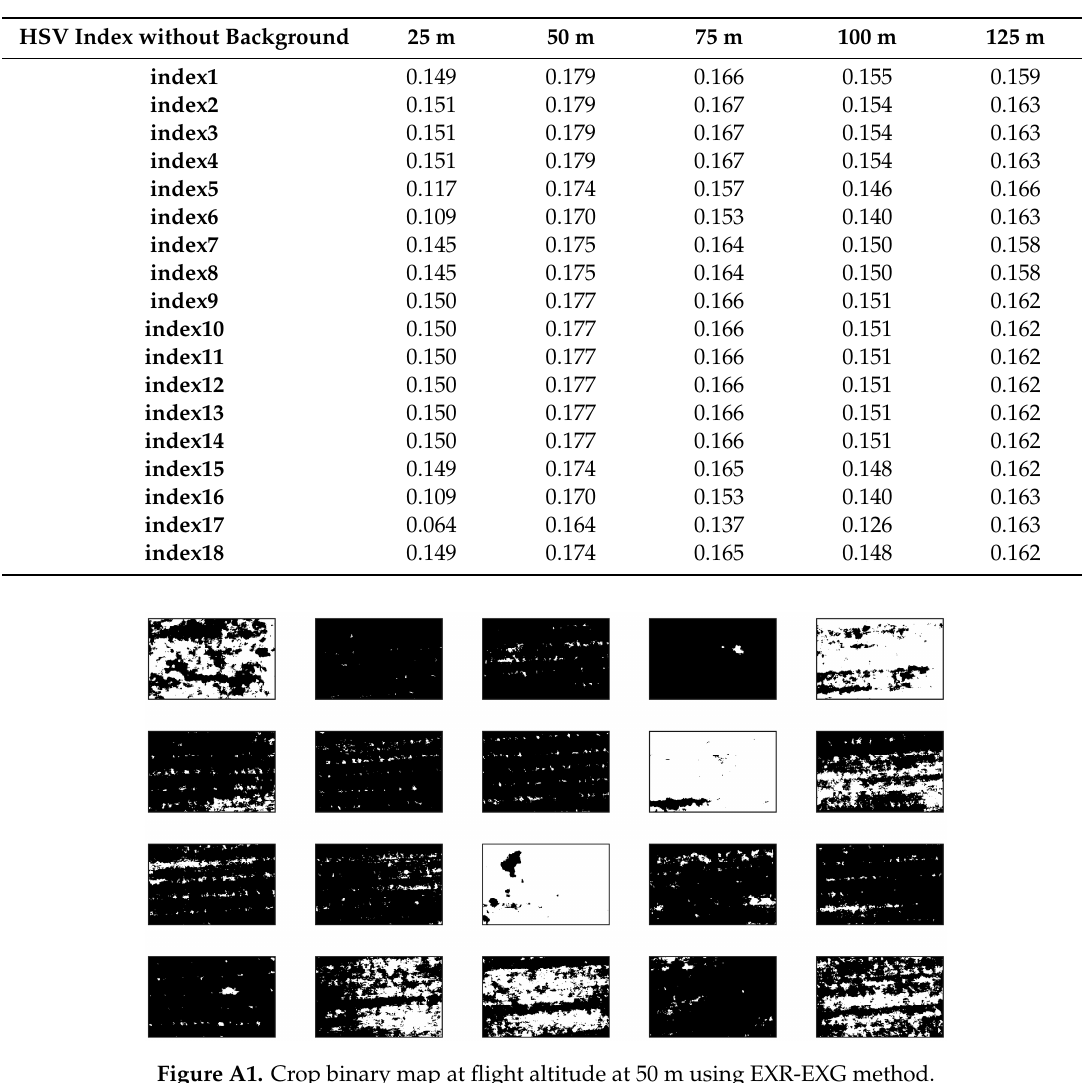
Table A4. The R 2 between vegetation indices calculated from HSV and chlorophyll contents using the images without background.